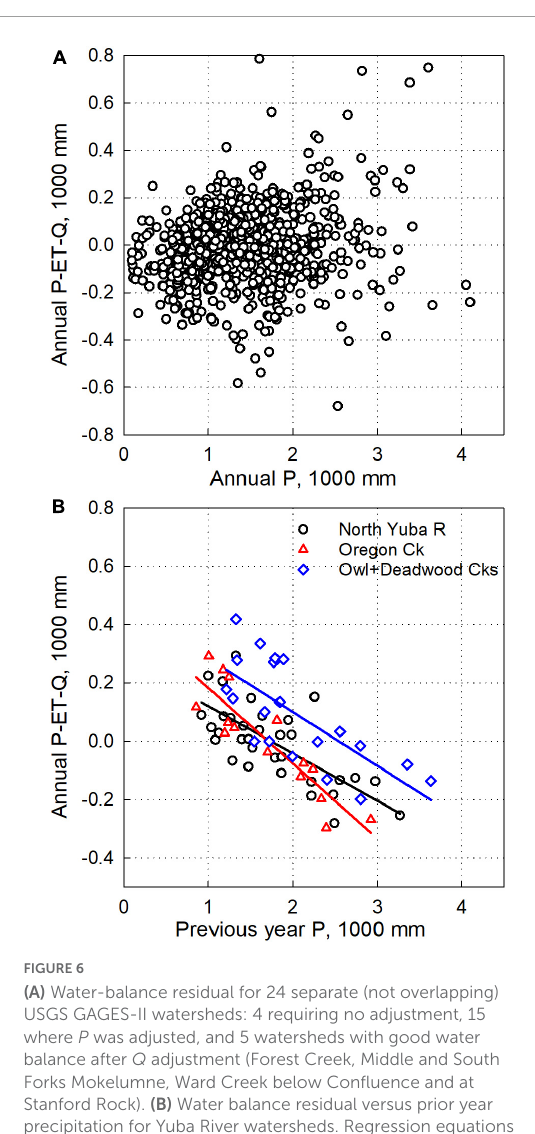
FIGURE6 (A) Water-balance residual for 24 separate (not overlapping) USGS GAGES-II watersheds: 4 requiring no adjustment, 15 where P was adjusted, and 5 watersheds with good water balance after Q adjustment (Forest Creek, Middle and South Forks Mokelumne, Ward Creek below Confluence and at Stanford Rock). (B) Water balance residual versus prior year precipitation for Yuba River watersheds. Regression equations are: ResidualNorthYuba = –0.1621 × PriorYearP + 282 , R 2 = 0.51 ( p < 0.0001), ResidualOregonCk = –0.2581 × PriorYearP + 440 , R 2 = 0.79 ( p < 0.0001), ResidualOwl + Deadwood = –0.1842*PriorYearP + 468 , R 2 = 0.51 ( p = 0.0004).